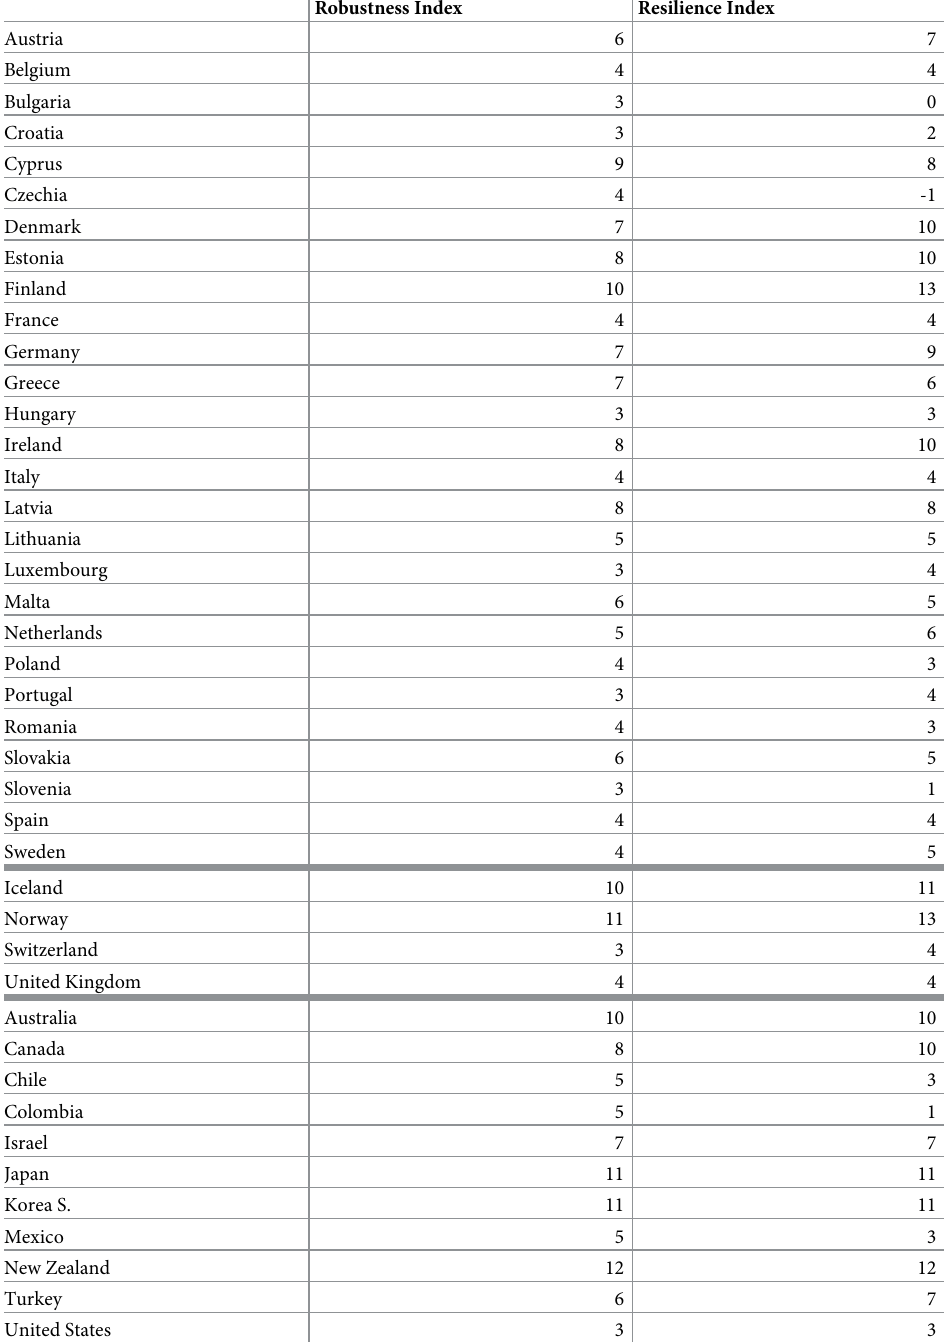
Table 4. Robustness and Resilience